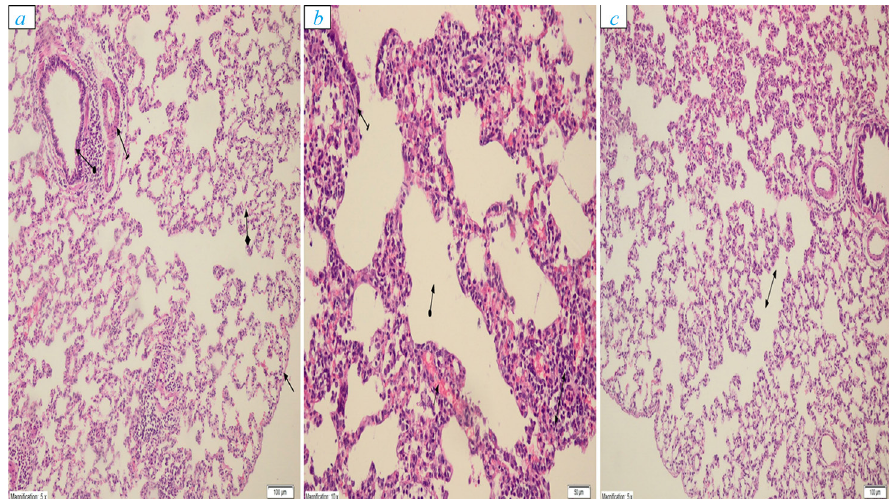
Figure 6. ( a ) Healthy visceral pleura (plain arrow), alveoli (square arrow), pulmonary artery (striated arrow) and bronchial (round-end arrow) structures in the lung tissue of the rats in the healthy control (HG) group (H&E, 100×). ( b ) The lungs of the rats in the cytarabine (CYT) group show diffuse oedema (round-end arrow), dilated and congested blood vessels (straight arrow), diffuse chronic inflammatory cell infiltration (double-sided arrow) and bronchial damage (striated arrow) (H&E, 200×). ( c ) Except for mild oedema (double-sided arrow), the pulmonary tissues of the rats in the rutin+cytarabine (R+CYT) group show a healthy appearance (H&E,